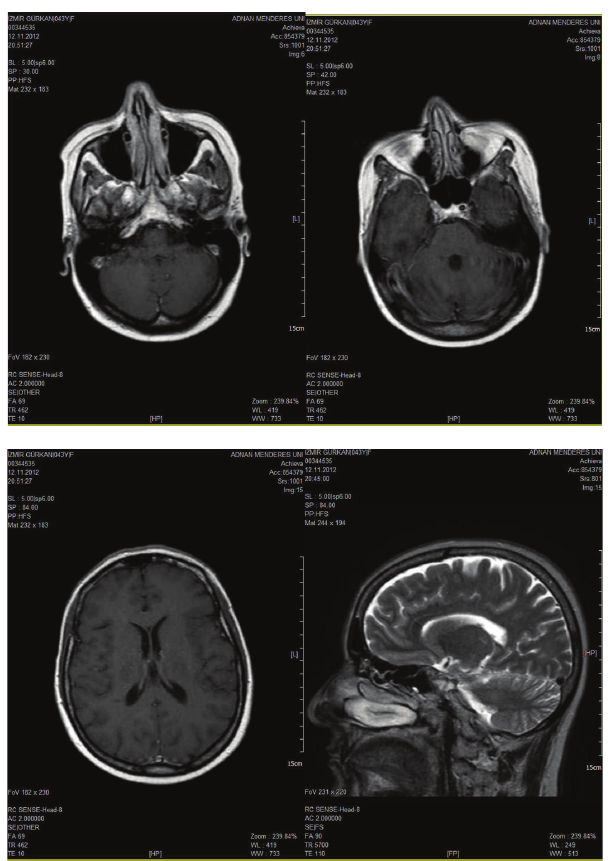
Figure 2: Magnetic resonance imaging scans demonstrating near complete resolution of brain metastases after lapatinib plus capecitabine